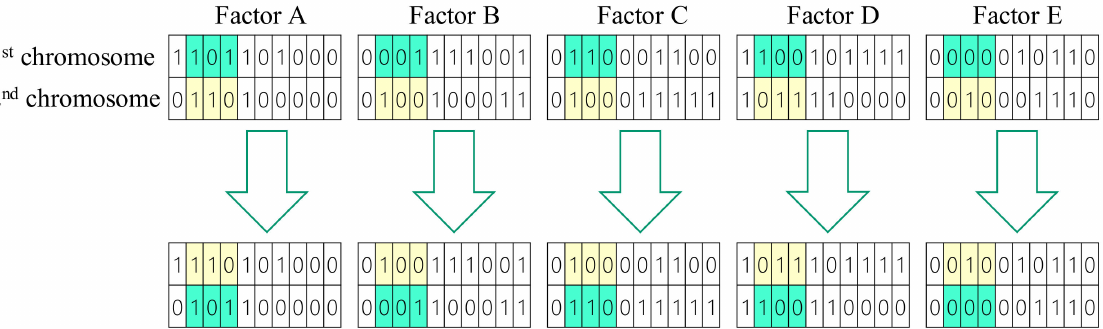
Figure 7. The two-point crossover